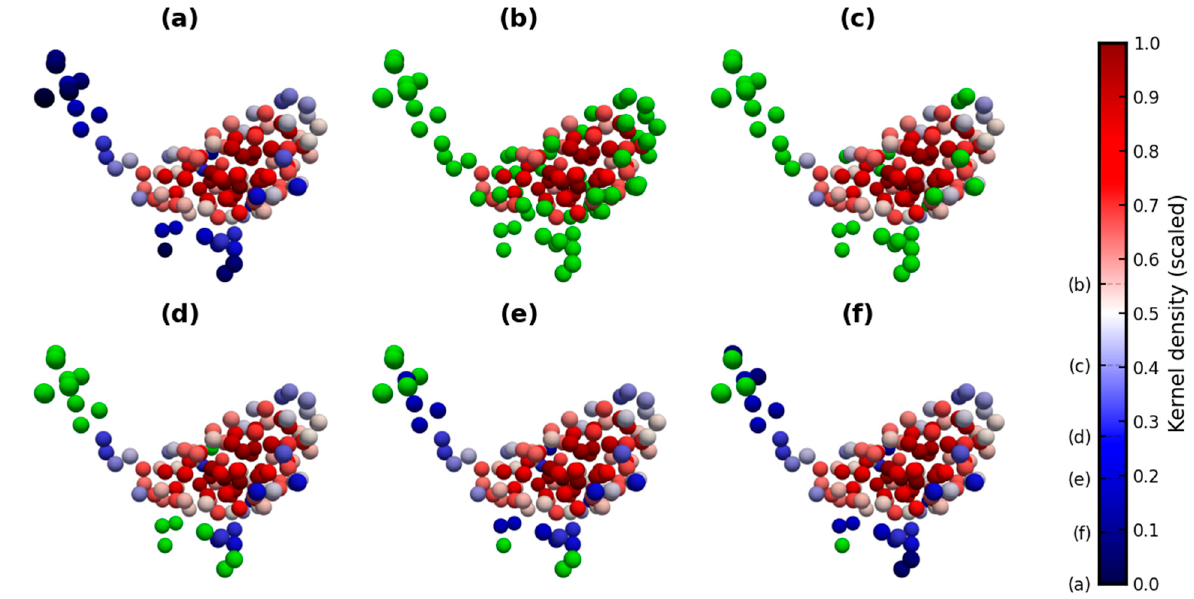
Figure 2. Influence of value of parameter m on classification of effective atoms of monomer of dUTPase YncF (4B0H) as guides (spheres colored in accordance with their kernel density values) and outliers (green spheres, with kernel density below m -based threshold t ) : m = 0/ t = 0.00/130 guides/0 outliers ( a ); m = 1/ t = 0.55/65 guides/65 outliers ( b ); m = 2/ t = 0.40/98 guides/32 outliers ( c ), m = 3/ t = 0.27/114 guides/16 outliers ( d ); m = 4/ t = 0.19/122 guides/8 outliers ( e ) and m = 5/ t = 0.09/126 guides/4 outliers ( f ). See Figure 1d for the associated density profile. Values of t and names of subfigures where they are applied are marked on the left of the color bar.